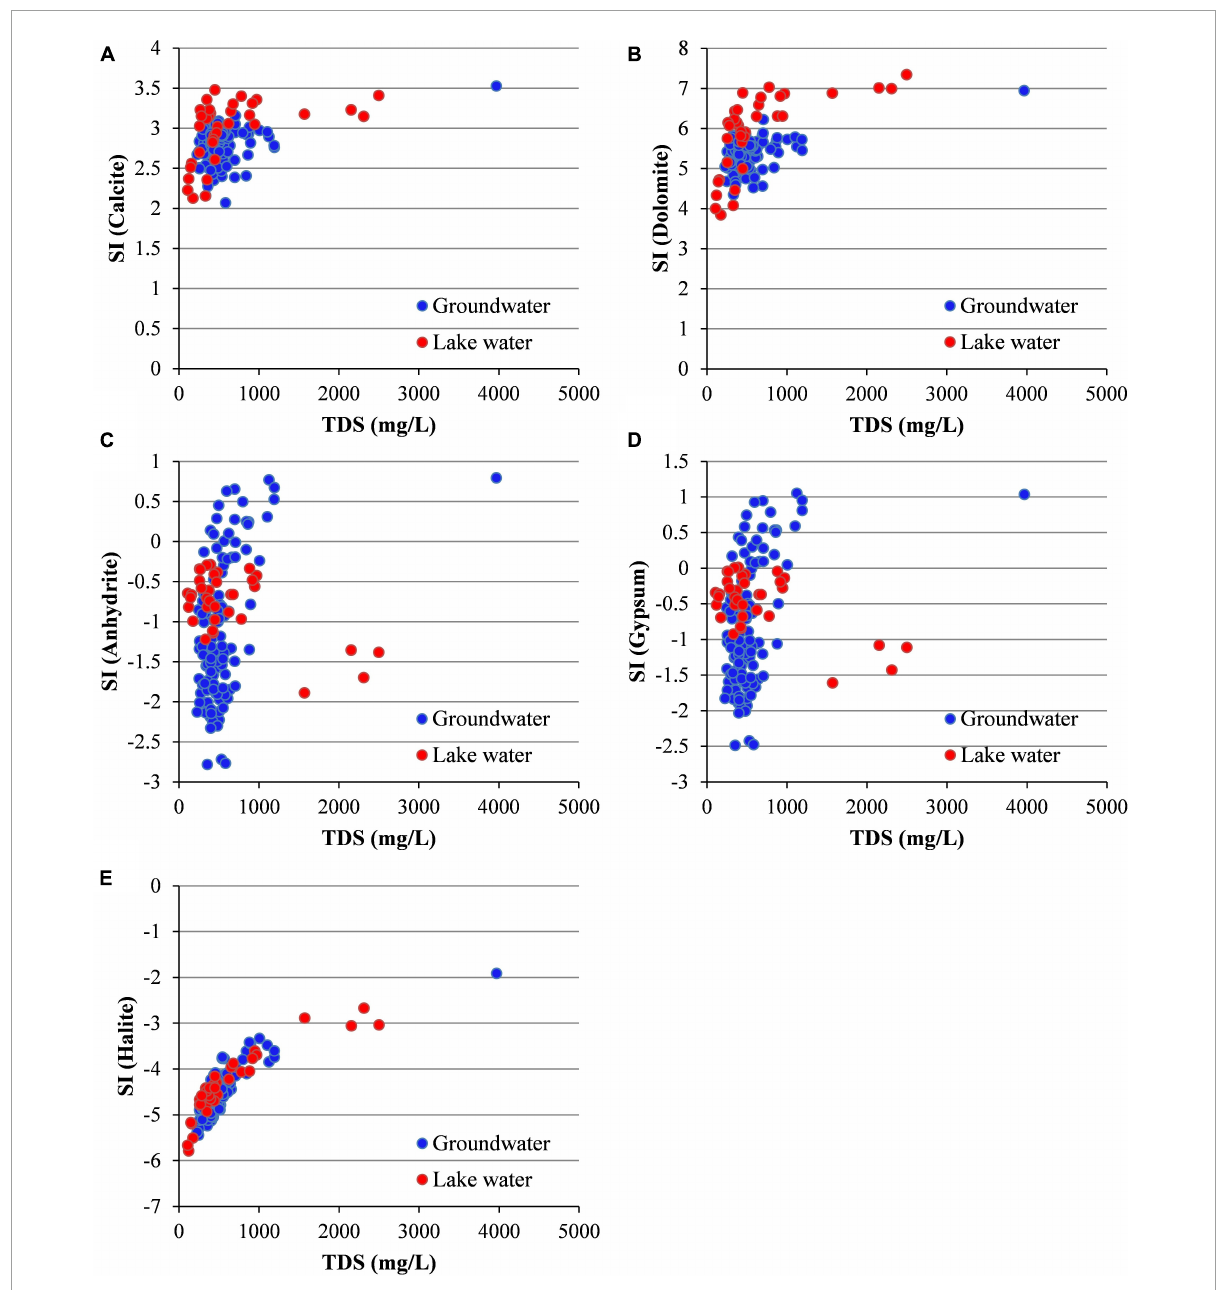
FIGURE6 Saturation indices (SI) of water samples for selected minerals. (A) Calcite; (B) dolomite; (C) anhydrite; (D) gypsum; (E)